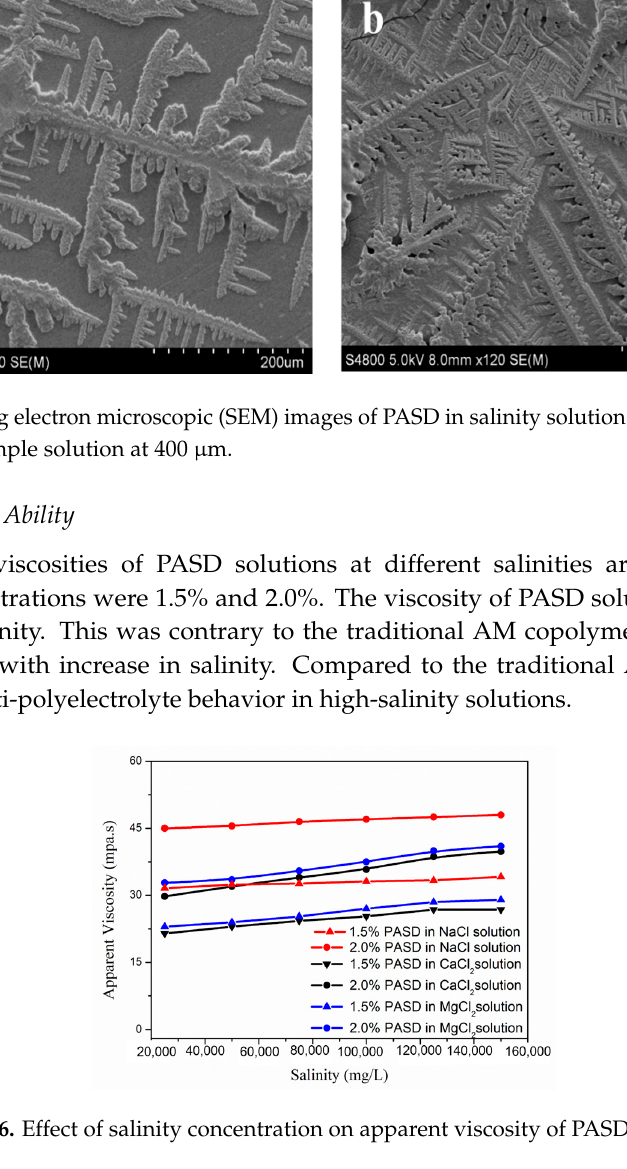
Figure 7. Thickening mechanism of PASD chains in ( a ) fresh water; ( b ) the low-salinity solution; and ( c ) the high-salinity solution.